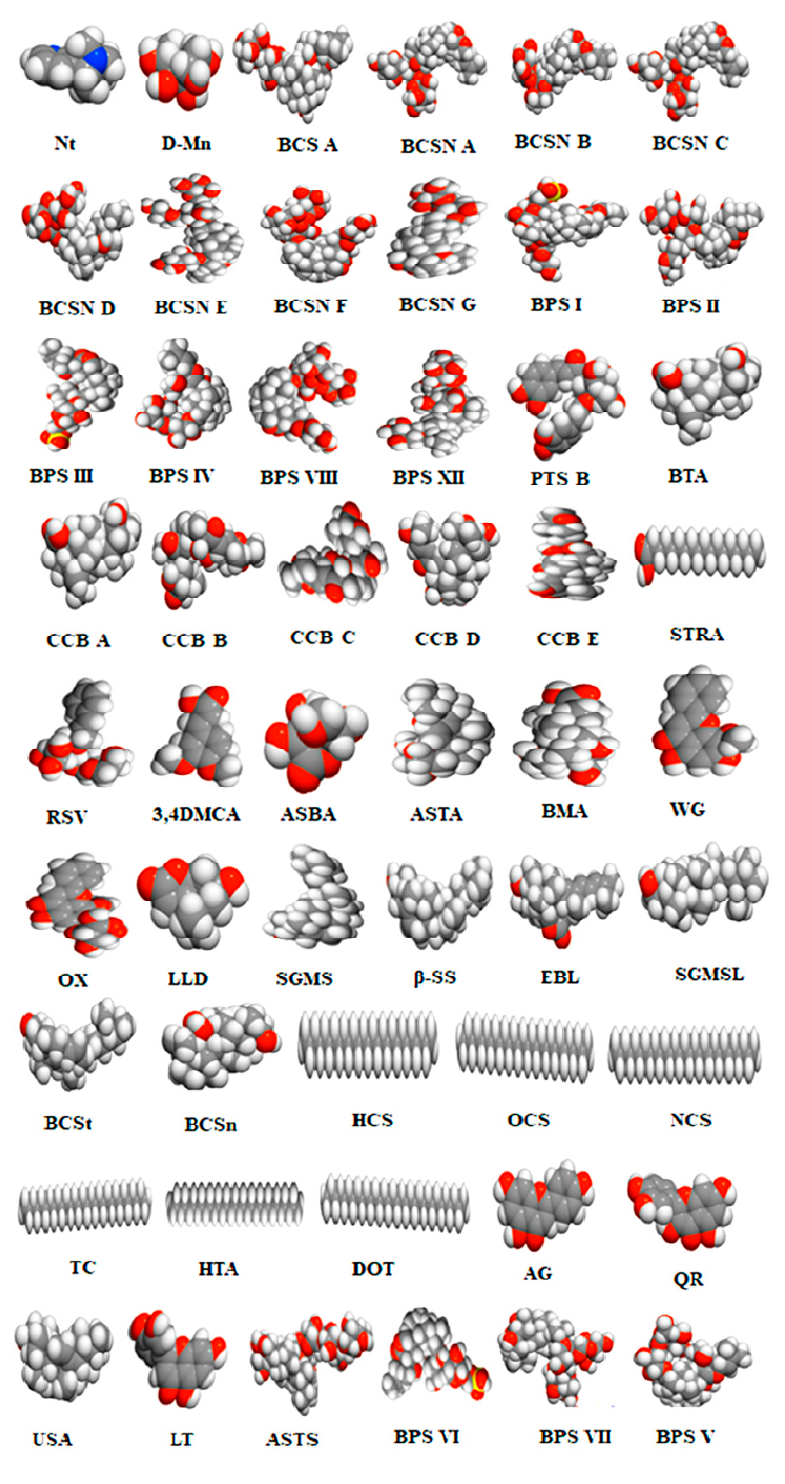
Figure 1. Phytomolecules and their 3D Figure 1 : Phytomolecules and their 3D structures